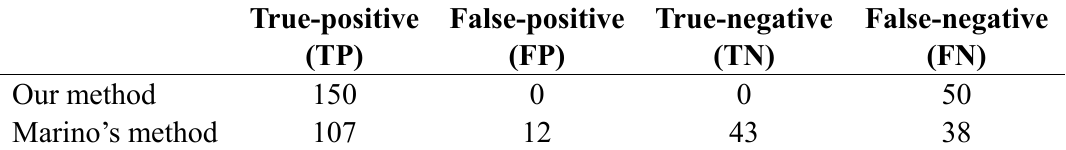
Table 5. Recognition rate using our method and Marino’s